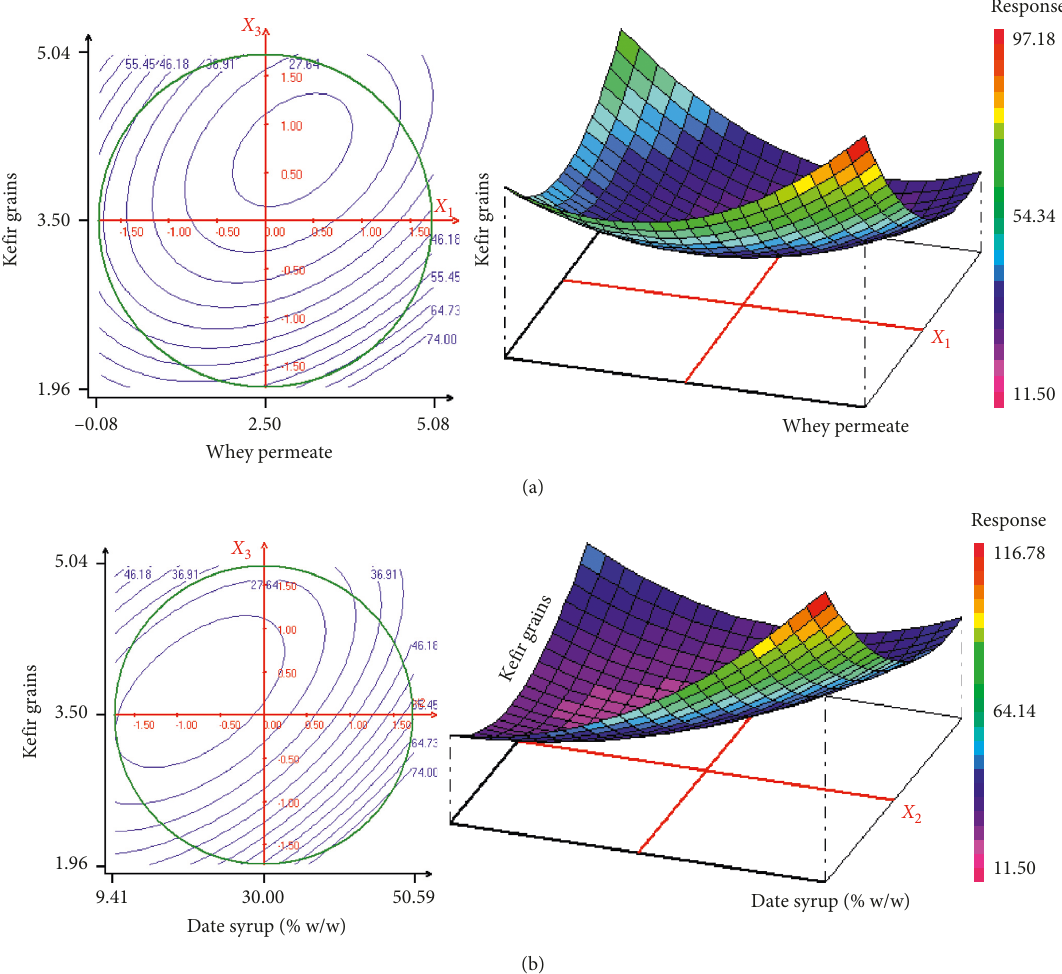
Figure 2: Response surface and contour plots that represent the effect of WP and kefir grains (a) and the effect of kefir grains and date syrup on polyphenol content (mg GAE/ml) (b).